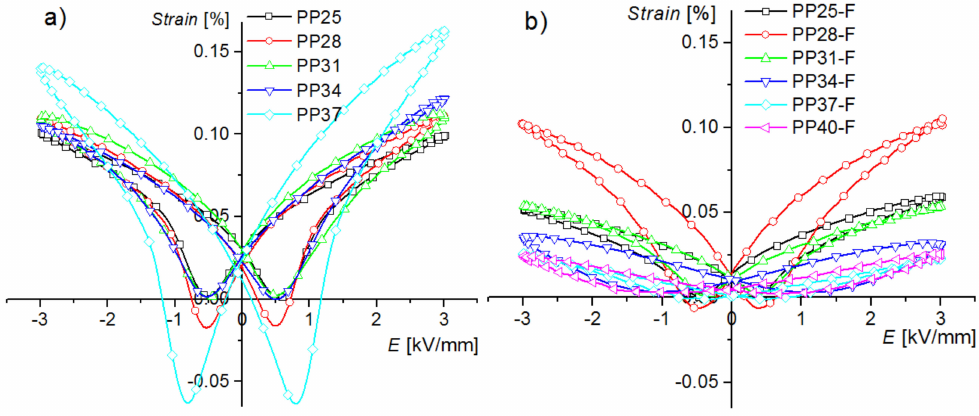
Figure 8. Bipolar strain-electric field loops ( S – E ) for ( a ) PP ceramics and ( b ) PP-F composite materials.